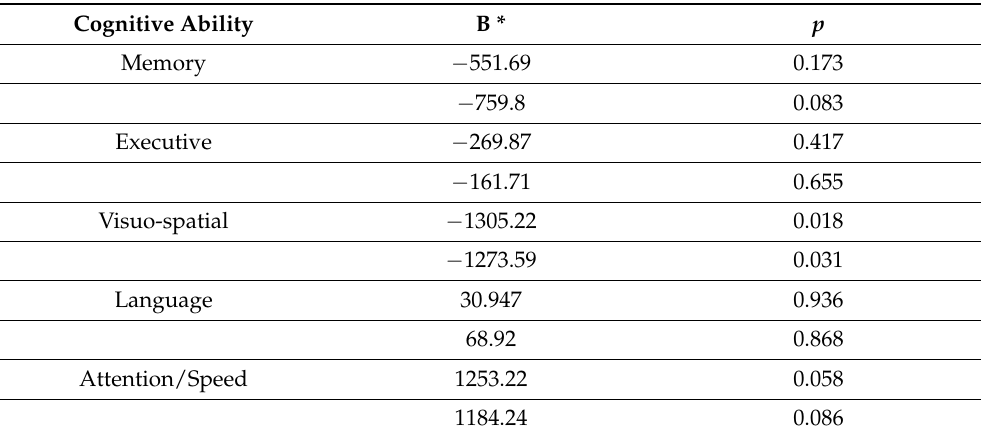
Table 2. Association between Sleep PRS and cognitive changes. First, the unadjusted model, and then adjusted for age, sex, education, PC1, PC2, and ApoE - ε 4.